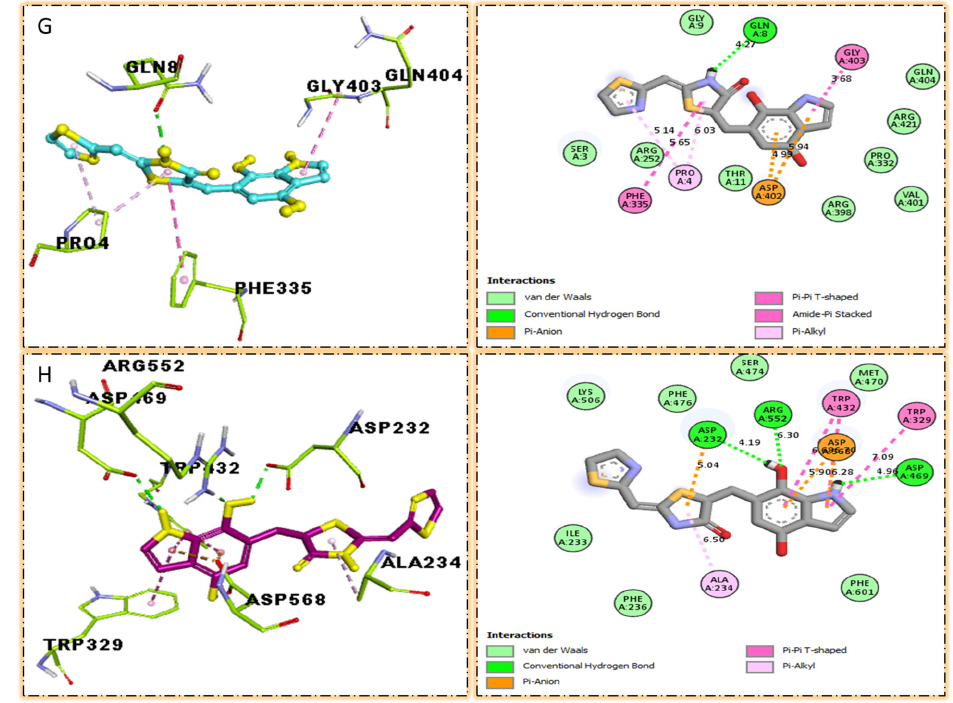
Figure 12. The surface of the relevant enzyme is represented by the PLI profile for drugs that are effective against Alpha-amylase and Alpha-glucosidase. The PLI profile for chemical 7 is shown by ( G , H ). Table 5. Represent the binding affinities and best mode RMSD of analog 7 against Alpha-amylase and Alpha-glucosidase .